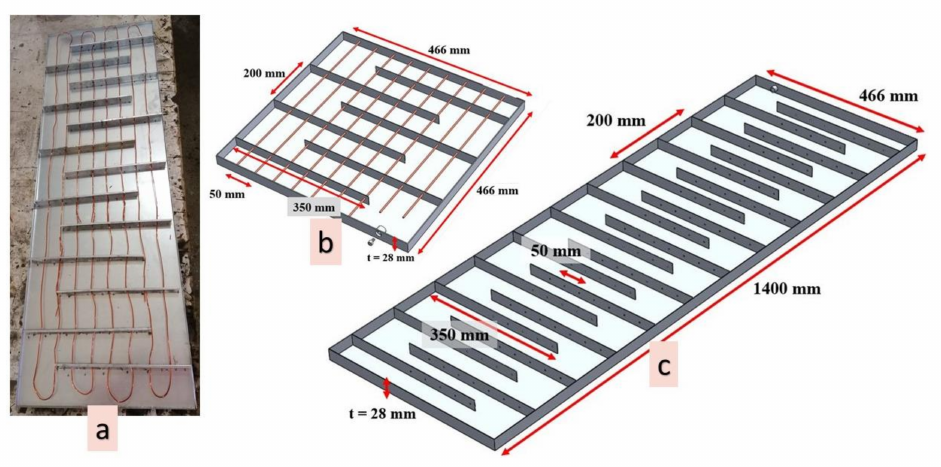
Figure 17. Installation of different layers to form a complete prototype.